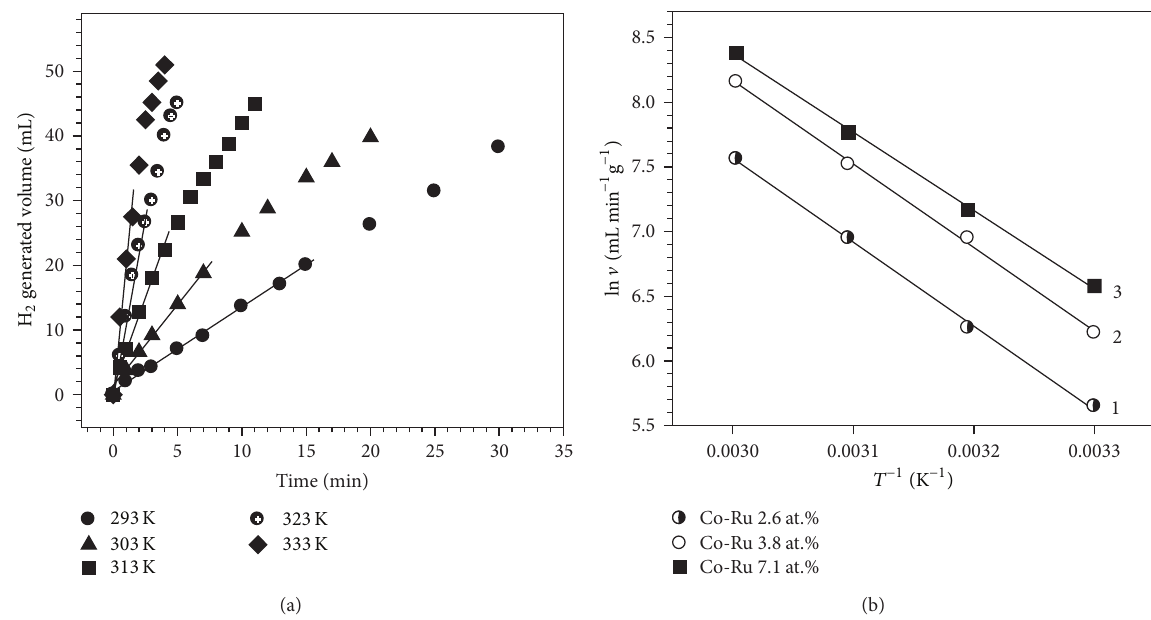
Figure 6: (a) Hydrogen generation kinetic plots of the 0.1 NaBH 4 + 0.25 mol/L NaOH solution employing the Co-Ru (3.8 at%) catalyst (5mg) at indicated temperatures. (b) The Arrhenius plots calculated from NaBH 4 hydrolysis rates in the same solution for various Co-Ru alloy catalysts.